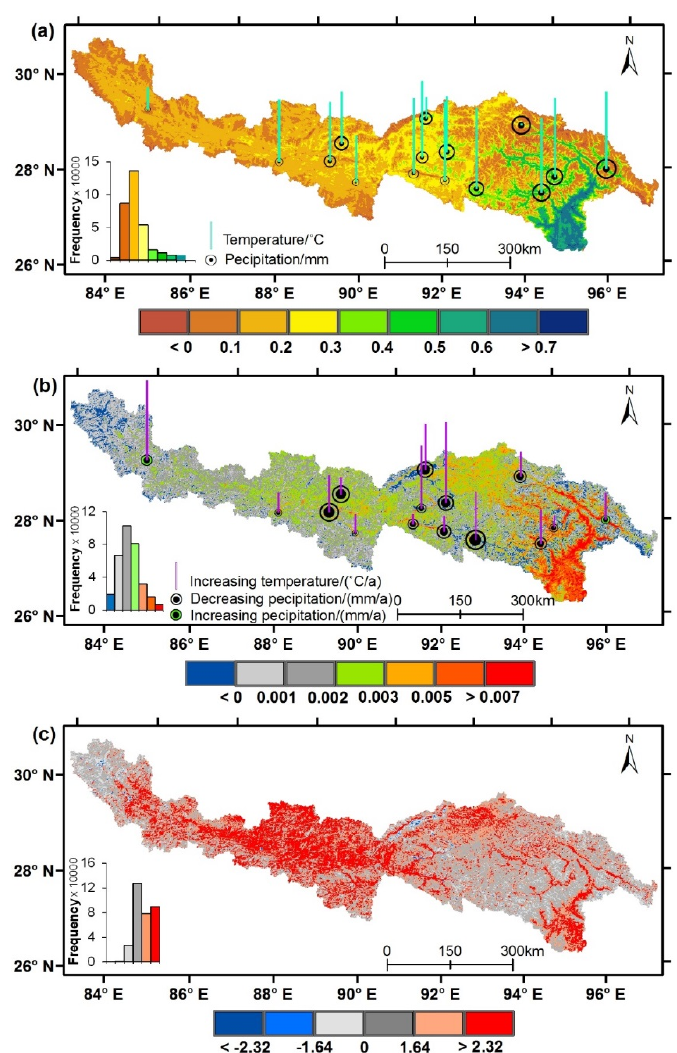
Figure 3. Spatial patterns of multi-year average NDVI ( a ), greening rate ( b ), and Z-value ( c ) in the YZR basin during 1999–2013. ( a ) The range of annual mean temperatures is from 0.22 °C to 9.78 °C, and annual precipitation ranges from 200 mm to 841 mm; and ( b ) the range of warming rate is 0.011 °C ∙ y − 1 to 0.09 °C ∙ y − 1 , and precipitation changing rate ranges from − 17.42 mm ∙ y − 1 to 1.97 mm ∙ y − 1 ; ( c ) Z-value was calculated using the M–K test, and the absolute Z values of ≥ 1.64 and ≥ 2.32 indicate the confidence level 95% and 99%, respectively.